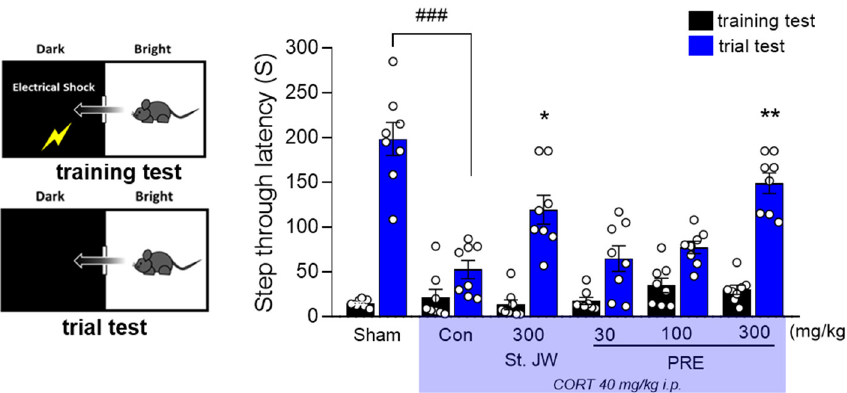
Figure 3. Effect of PRE on passive avoidance test in CORT-induced depressive mice. CORT injec- tions significantly decreased step-through latency time (s), while administration of PRE at doses of 300 mg/kg significantly increased latency time. Results are presented as mean ± SEM ( n = 8, per group). ### p < 0.001 versus the sham group; * p < 0.05 and ** p < 0.01 versus the CORT-injected Con group. Con, control; CORT, corticosterone; St. JW, St. John’s wort extract; PRE, P. resupinata extract.